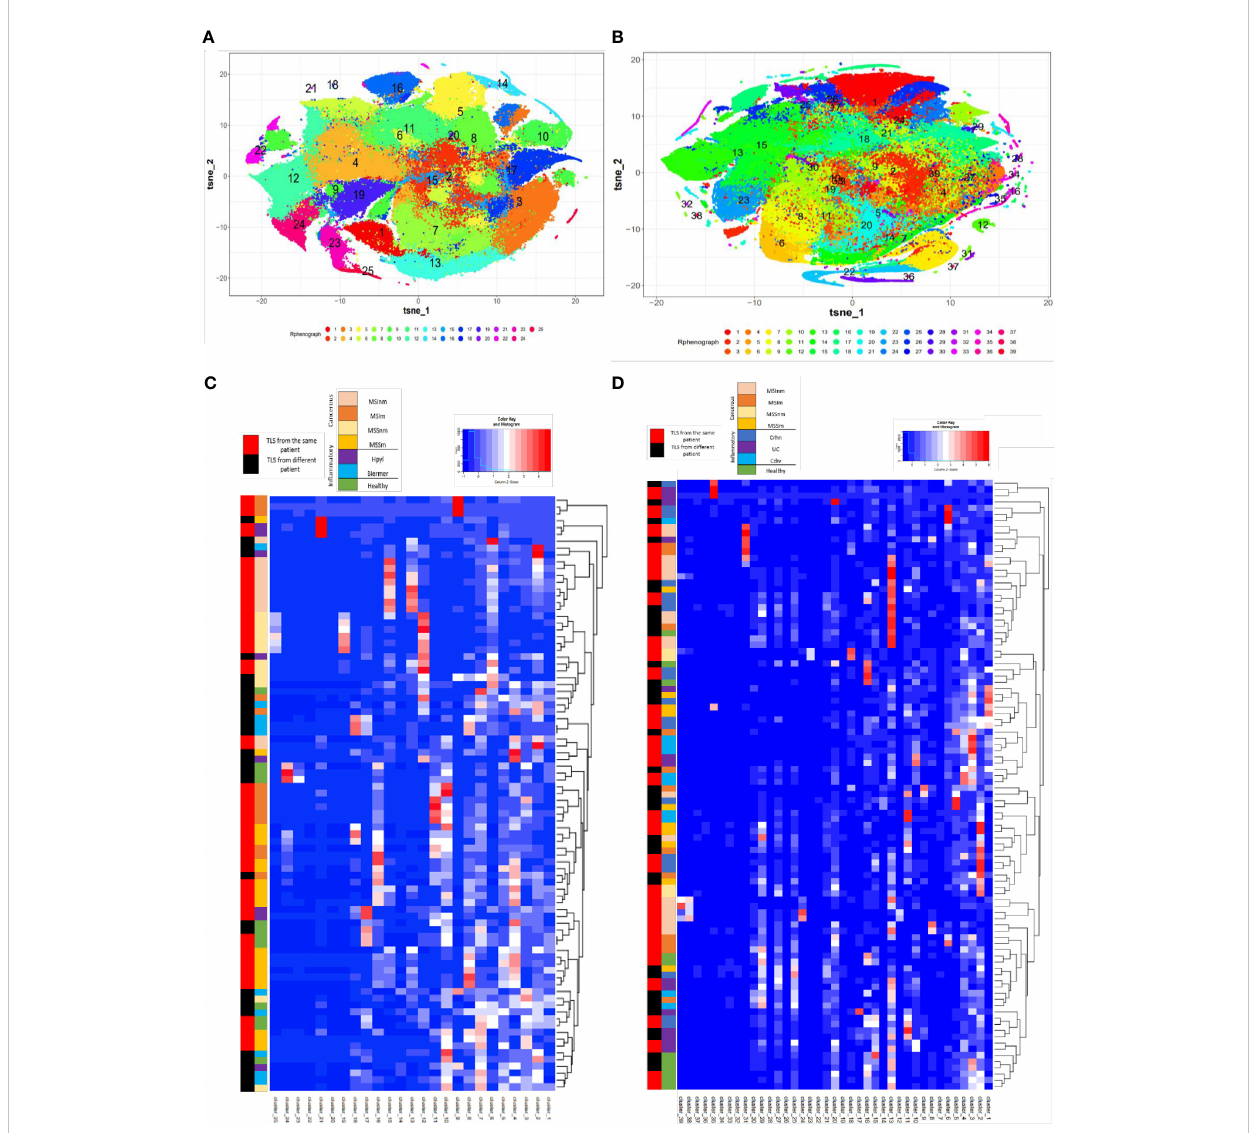
FIGURE 1 T-sne plots and the corresponding heatmaps of the cellular clusters obtained with Rphenograph composing TLS in gastric and colonic samples. (A) T-Sne plot showing the cellular composition of each TLS in gastric samples (excluding LN) composed of 25 clusters. (B) T-Sne plot showing the cellular composition of each TLS (excluding LN) composed of 39 clusters in colonic samples. (C) Heatmap about gastric data shows median marker expression of clusters detected by RPhenoGraph in TLS coming from the different conditions 1) healthy, 2) in fl ammatory: Hpyl = patient with infection by Helicobacter pylori, Bierm = patient with Biermer ’ s disease, and 3) cancerous: patients with adenocarcinoma of MSI- or MSS- status, with a non-metastatic (-nm) or metastatic stage (-m). (D) Heatmap about colonic data shows median marker expression of clusters detected by RPhenoGraph in TLS coming from the different conditions 1) healthy, 2) in fl ammatory: Crhn = patient with Crohn ’ s disease, UC = patient with ulcerative colitis, and Cdiv = patient with chronic diverticulitis, and 3) cancerous: patients with adenocarcinoma of MSI- or MSS- status, with a non-metastatic (-nm) or metastatic stage (-m). For (C, D) heatmaps, row labels represent the cluster IDs and column labels show the TLS name. The multicolor line on the left represents the grouping of TLS according to their conditions where each color is speci fi c for a condition. The red and black line on the left represents in red the TLS that are closely grouped within the dendrogram and found in the same patient whereas in black are TLS from different